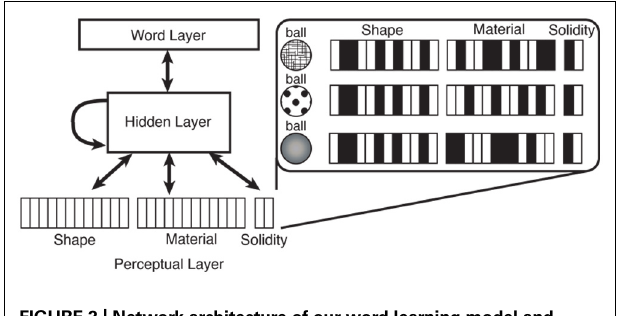
FIGURE 2 | Network architecture of our word learning model and example input patterns for a solid shape-based noun